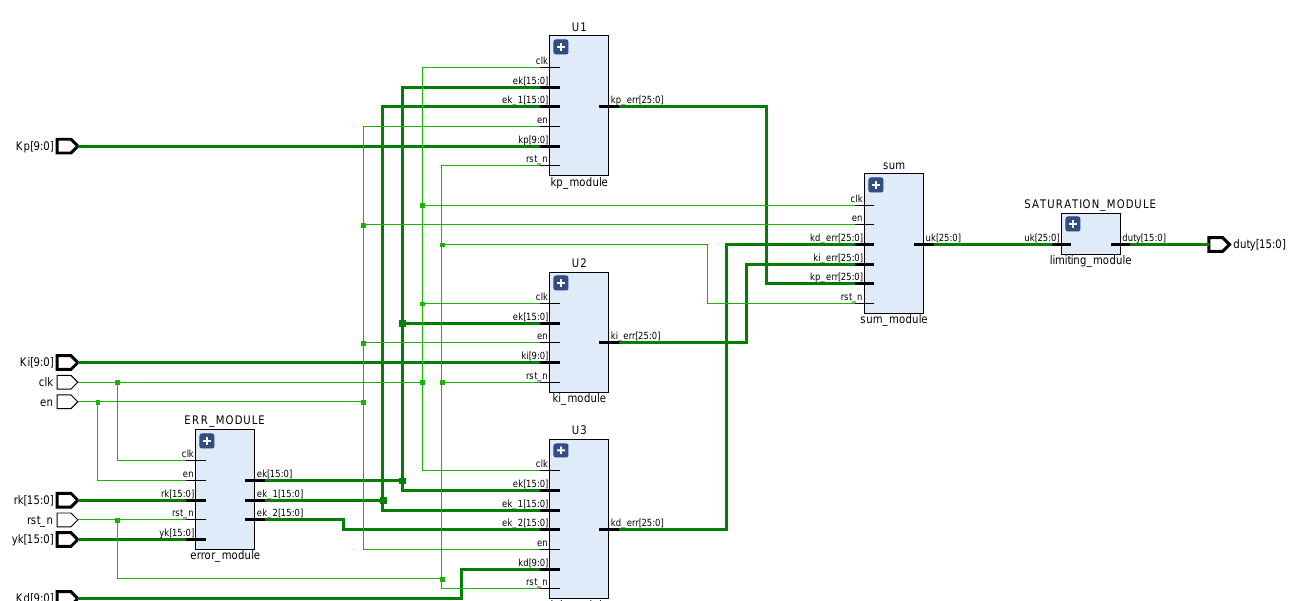
Figure 12. Structure of incremental PID control algorithm.